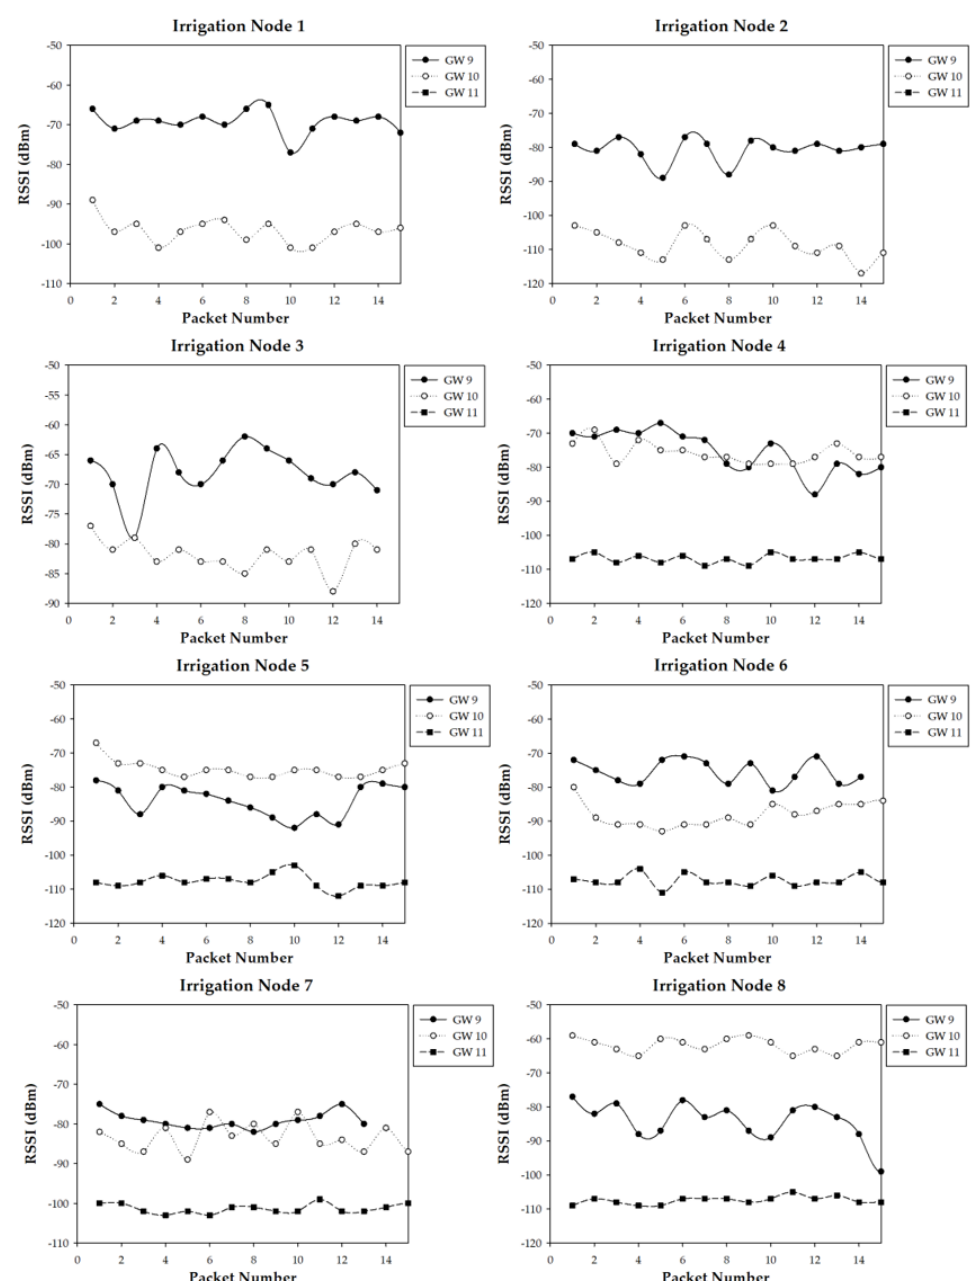
Figure 21. RSSI received by the gateways from the eight irrigation nodes (near-ground) that operate at 868